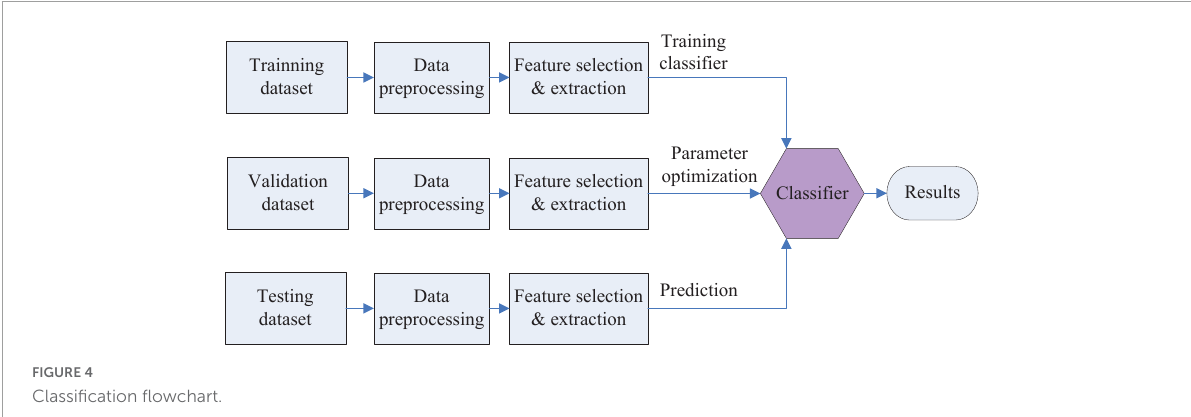
FIGURE4 Classification